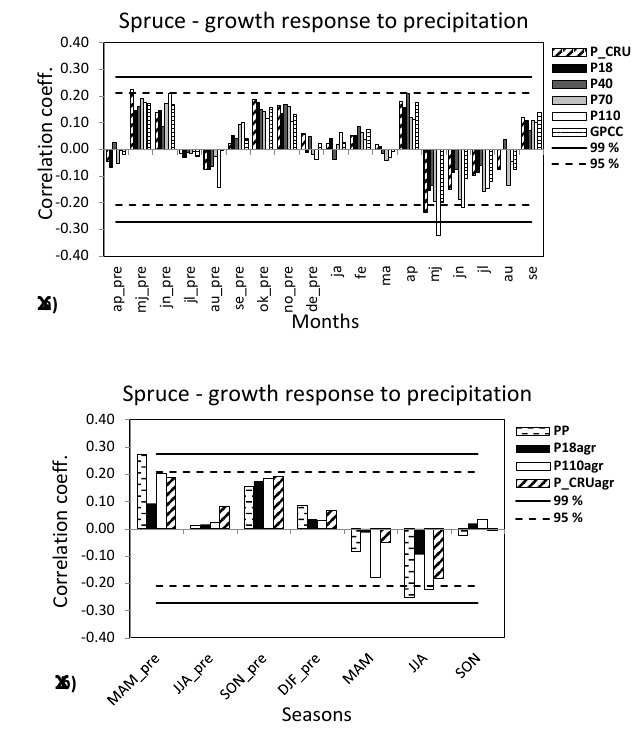
Figure 5. Growing response of spruce radial increment to data sets of (a) monthly precipitation totals, (b) seasonal precipitation totals.